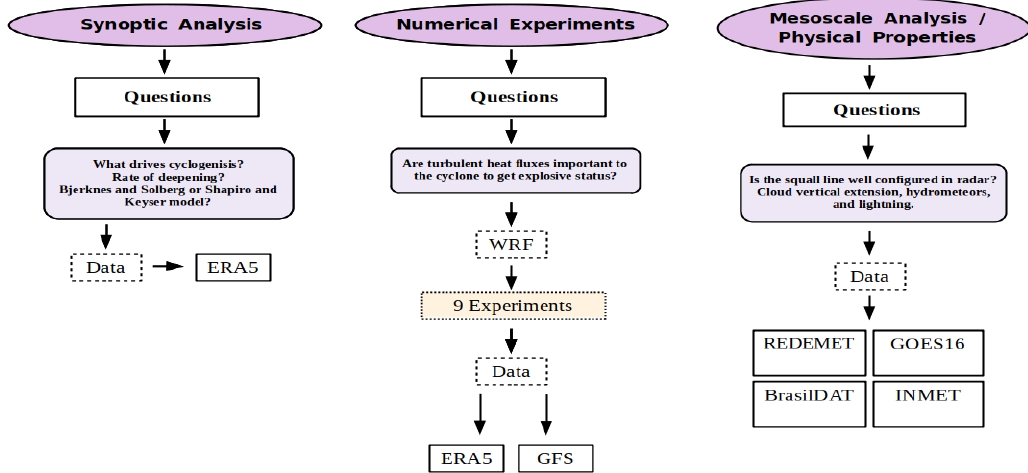
Figure 2. Flowchart summarizing scientific questions, methodology, and data applied in the present study.